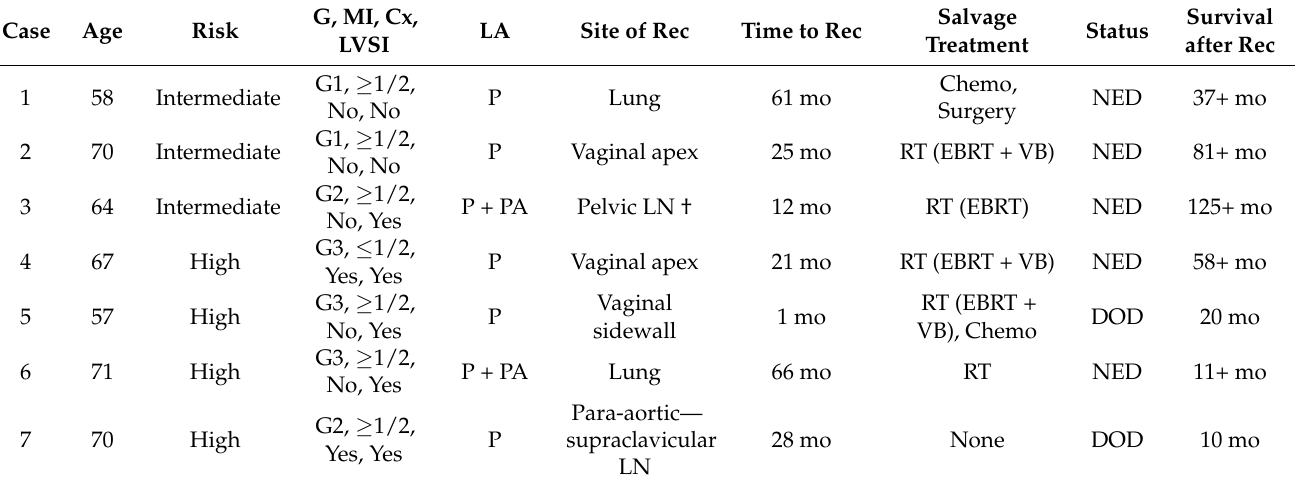
Table 2. Characteristics of the patients with uterine-confined endometrioid endometrial carcinoma who developed